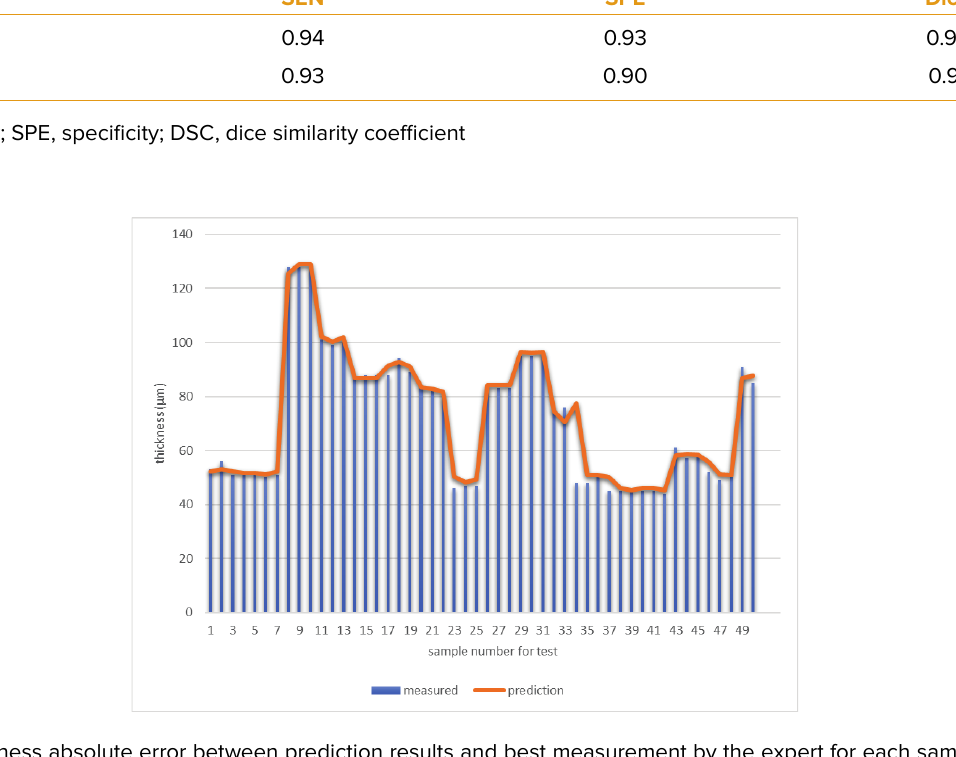
Figure 6. Thickness absolute error between prediction results and best measurement by the expert for each sample in the test set. MAE for 50 samples is equal to 2.23 ± 2.1(μm)..